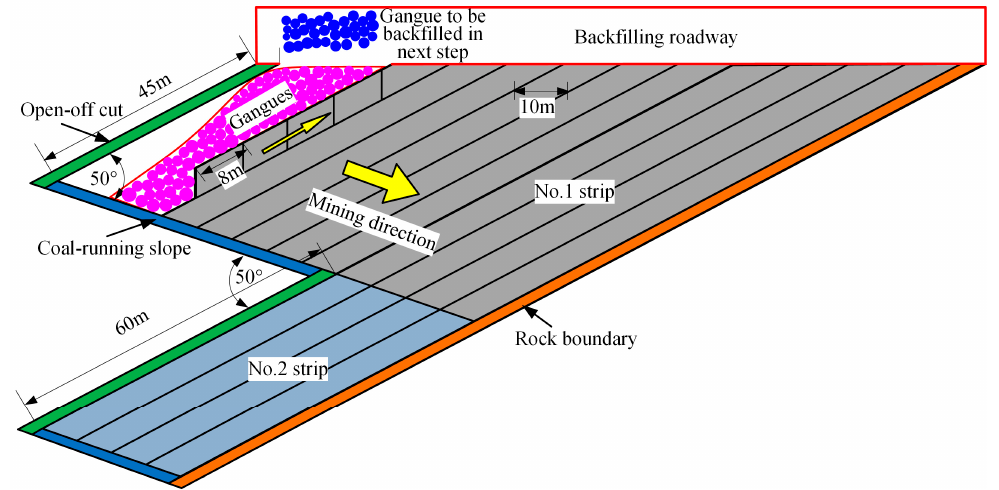
Figure 5. Gangue backfilling simulation model of slope flexible shield supporting mining.